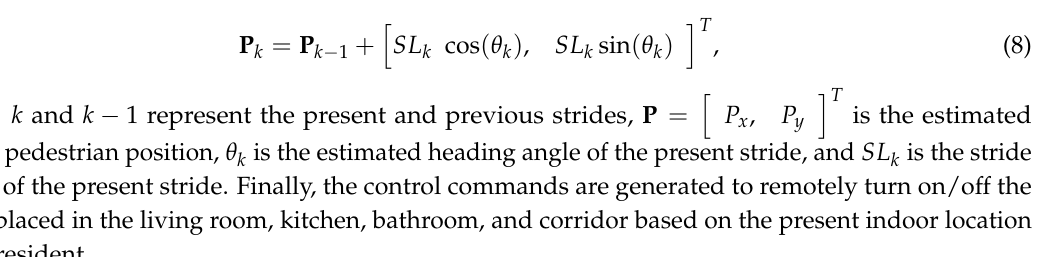
Figure 13. SVMs of the filtered angular velocities generated from walking movement. (Green color: Start points; Red color: End points).